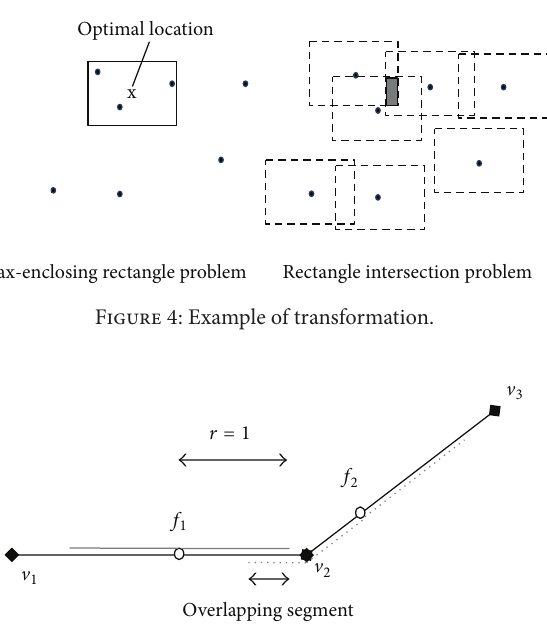
Figure 5: Max-segment in MaxRS query.